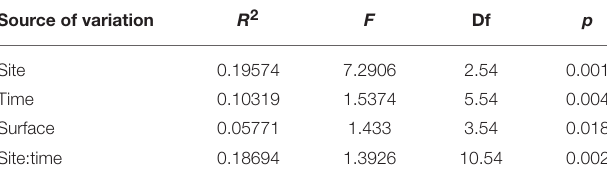
TABLE 3 | PERMANOVA testing for an effect sampling site, exposure time, and tile surface on the bacterial community composition on artificial ceramic tiles. Source of variation R 2